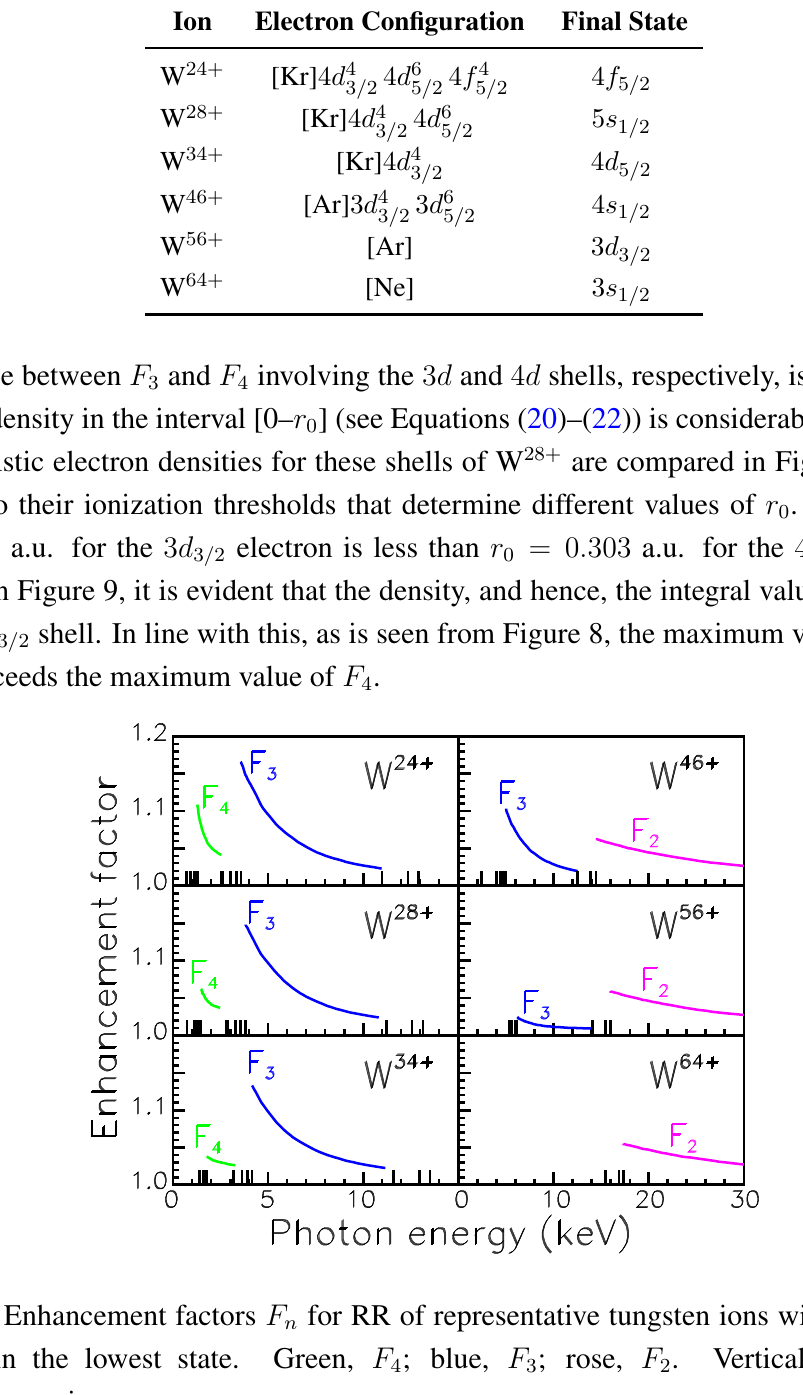
for RR of representative tungsten ions with an electron n ; blue, F ; rose, F . Vertical lines denote 4 3 2